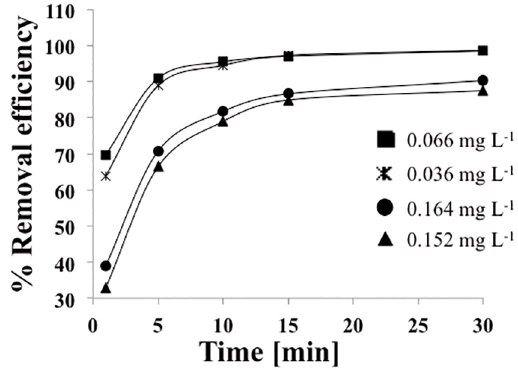
Figure 5: The removal efficiency of the As ions at different contact time. As +3 ions after 15 minutes of contact time reached only 87%.